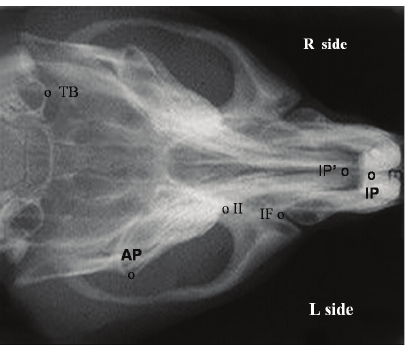
FIGURE 2 – Axial radiograph of the skull. TB = tympanic bulla, IP = incisal point of maxilla, IP’ = incisal point of mandible, AP = angular process, II = insertion of incisor, IF = infraorbital foramen.